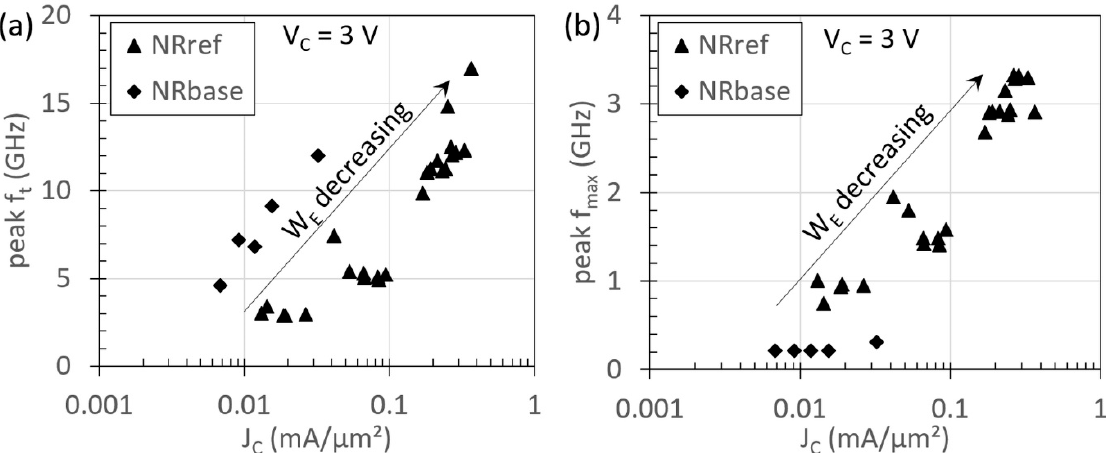
Figure 11. RF small-signal performance of nano-ridge engineered HBTs, consisting of different number of NRs. ( a ) Peak f t and ( b ) f max as a function of current density for devices from NRbase and NRref samples. The data shown are for W E in the range of 8 to 30 µm for NRref (A E 35 to 1334 µm 2 ) and 15 to 35 µm for NRbase (A E 160 to 627 µm 2 ). Peak f t exceeding 15 GHz are achievable for devices with W E ~8 µm. f max for NRbase is quite small as compared to NRref devices, owing to larger base doping in the latter.